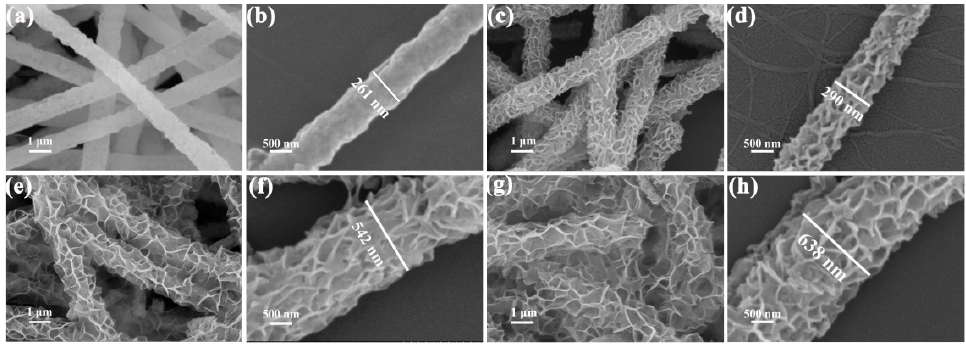
Scheme 1. Schematic diagram showing the construction of the NiMoO 4 @Ni(OH) 2 nanofibers.